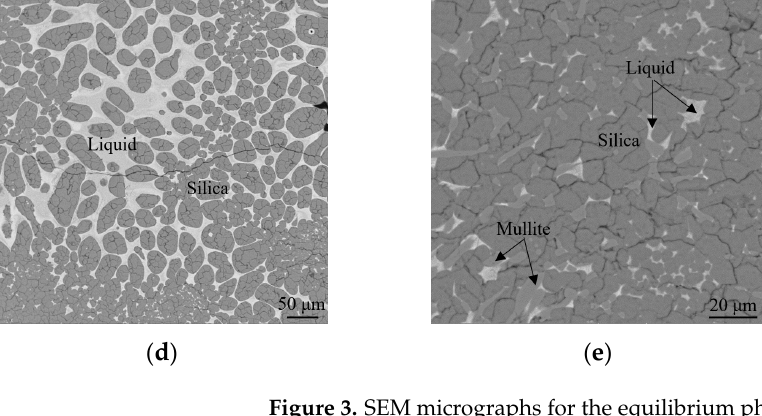
Figure 3. SEM micrographs for the equilibrium phases of sample B1 to B6 at 1400 °C in air. ( a ) B1 at